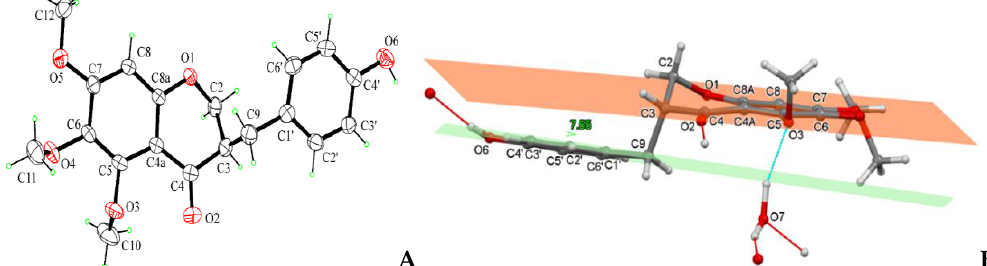
Figure 2. ( A ) ORTEP view of the homoisoflavanoid ( 1 ) molecular structure, with ellipsoids drawn at the 30% probability level. ( B ) Independent unit of compound 1 in a perspective view showing a quite parallelism between hydroxybenzene plane (green) and benzene ring of chromanone system (orange) (angle of 7.55° between the two planes). Ball-and-stick style. Hydrogen bonds drawn as cyan and red dashed lines.